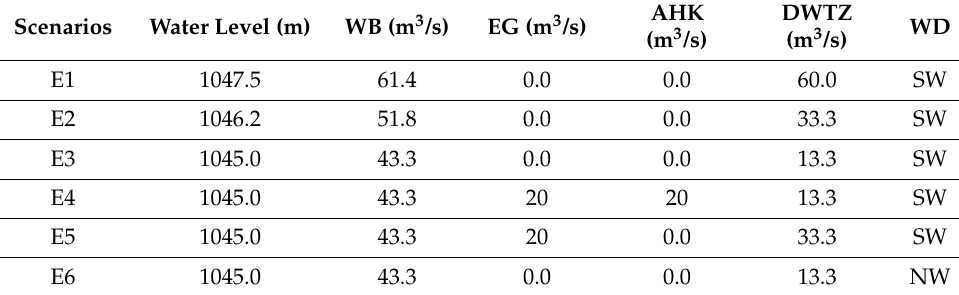
Table 2. The specific conditions of different